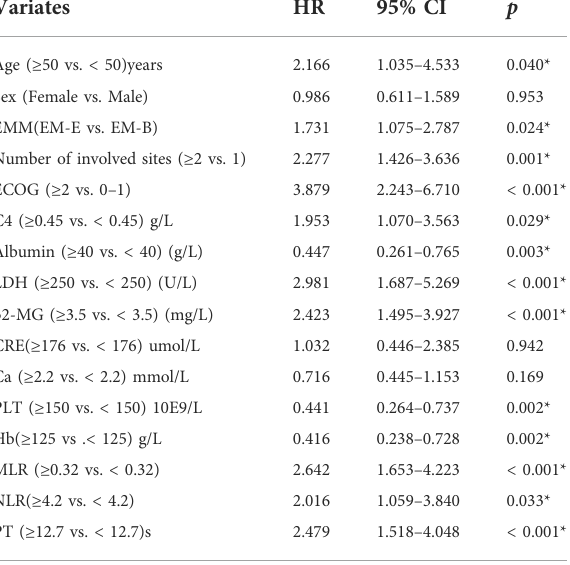
TABLE 3 Univariate analysis of OS in patients with EMD.